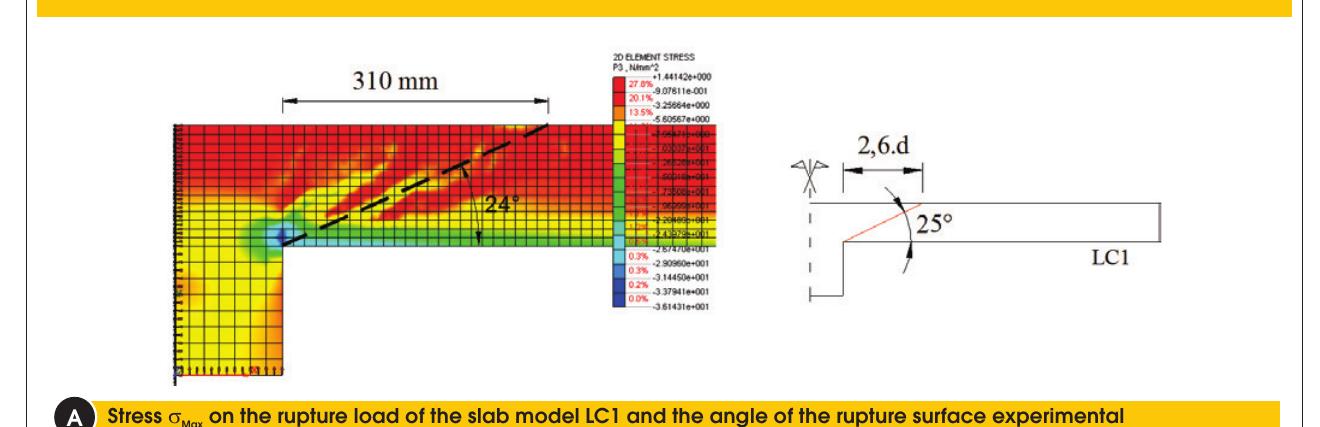
Figure 13 – Distribution of normal stresses of numerical models and the angle of the rupture surface observed in experimental slabs LC1, LC2, LC3 and